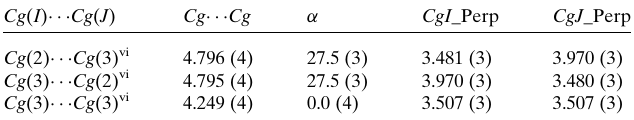
Table 2 Analysis of short ring–ring interactions (A˚ , (cid:4) ).